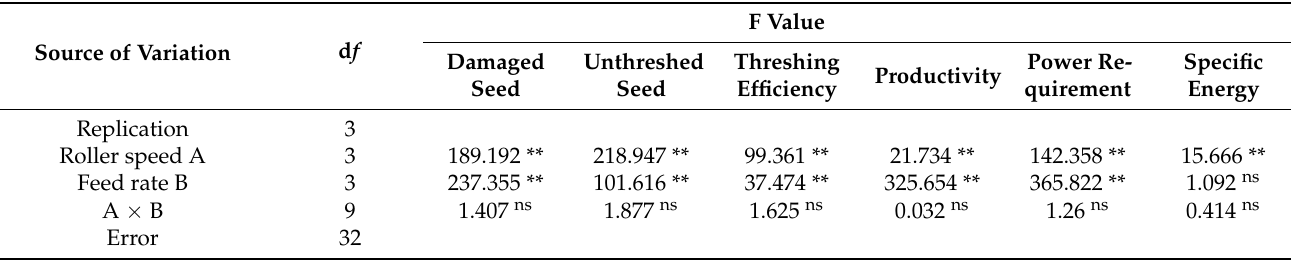
Table 1. Analysis of variance for the effectiveness of the study parameters on the performance of the sunflower threshing machine.